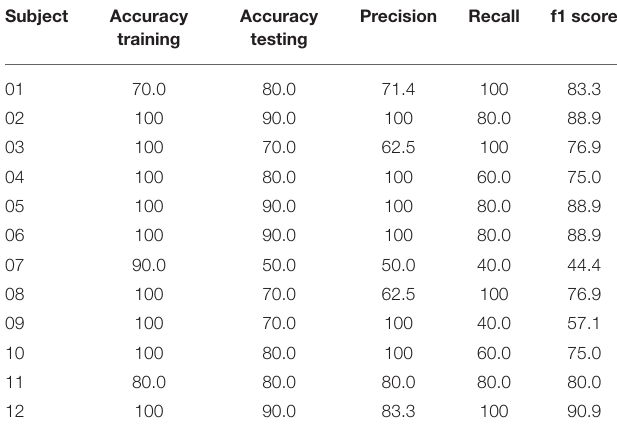
TABLE 2 | Real flight experiment: machine learning